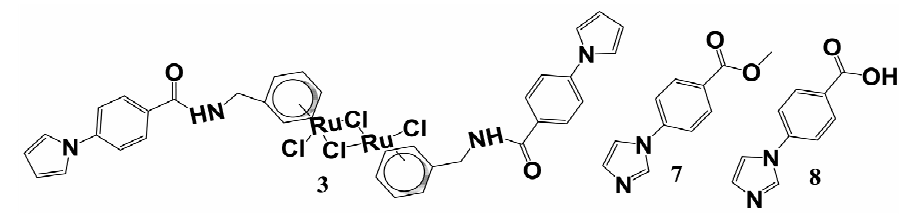
Figure 9. Structures for some synthesized compounds.